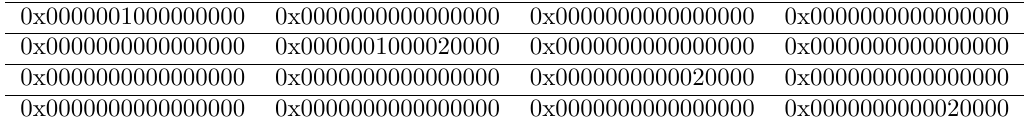
Table 4: Input difference in Phase 2.